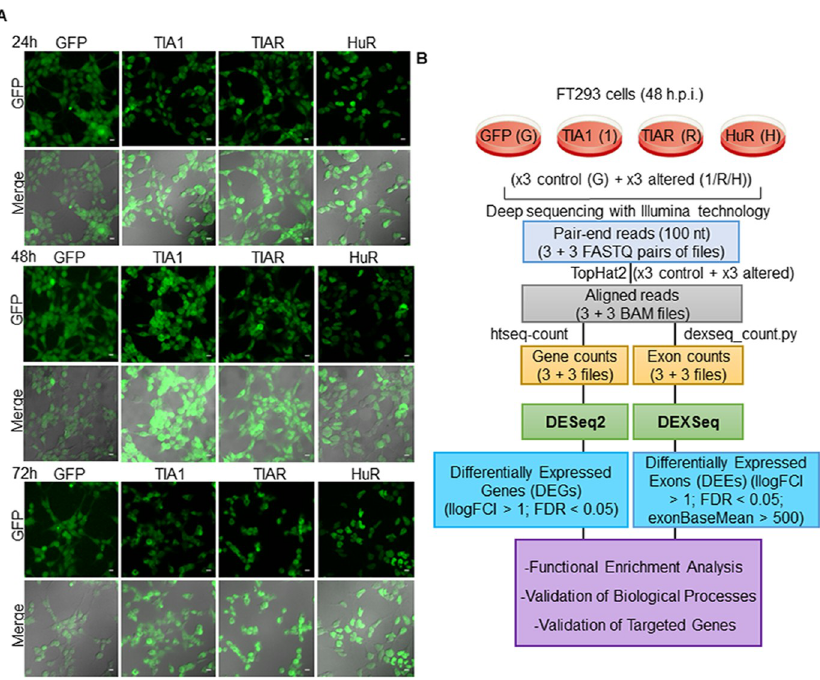
Fig 1. Characterization of the global transcriptomes of RBP-expressing FT293 cells by massive sequencing. (A) Expression patterns of GFP-tagged proteins. Fluorescence images together with corresponding phase contrast photographs (merge) are shown for 3 days. Scale bars represent 20 μ m. (B) Working pipeline of the RNA-seq analysis. Workflow followed to analyze the datasets from massive-scale RNA sequencing. The legend identified as G, 1, R, and H indicates GFP, TIA1b, TIARb, and HuR samples,